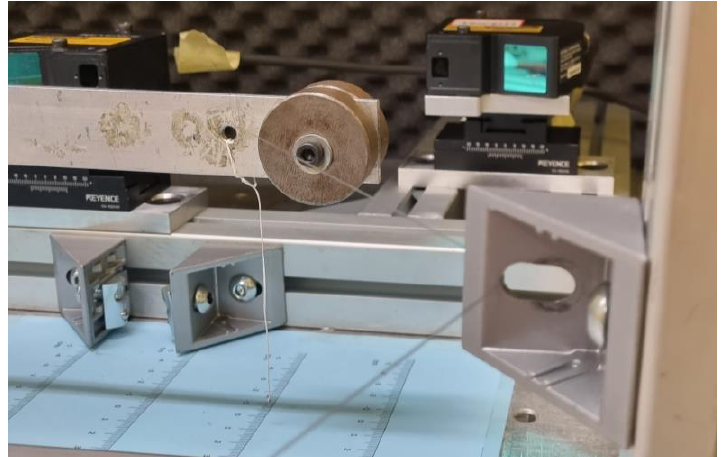
Figure 6. View of the method to excite the system with the desired initial condition.